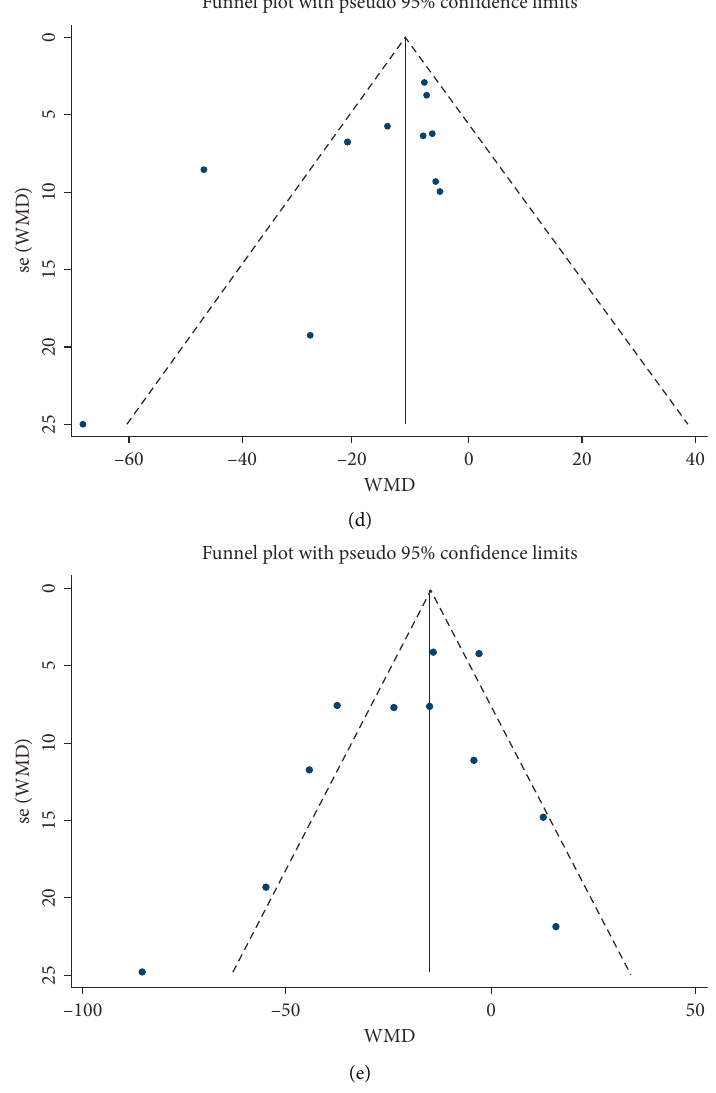
Figure 4: Funnel plot of EFT volume differences among different populations: (a) healthy participants and all AF cases; (b) healthy participants and paroxysmal atrial fibrillation; (c)) healthy participants and persistent atrial fibrillation; (d) paroxysmal atrial fibrillation and persistent atrial fibrillation; and (e) recurrent and nonrecurring patients after